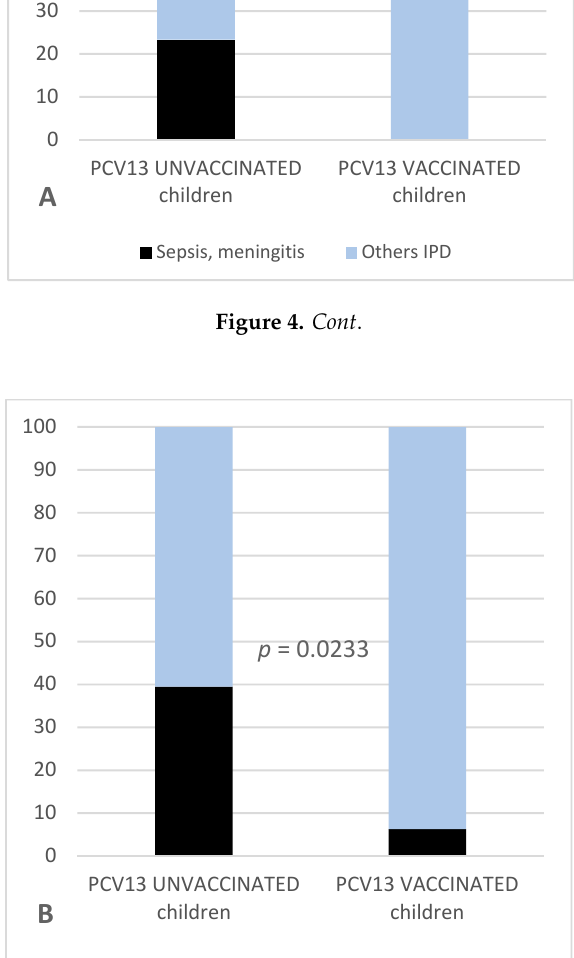
Figure 4. Percentage representation of the different forms of serotype 3 Streptococcus pneumoniae invasive pneumococcal disease (IPD) in children under 8 years of age, vaccinated with PCV13 and unvaccinated. Columns show internal group percentage subdivision based on clinical course severity: black represents sepsis and meningitis in panel A, with the addition of patients admitted to the pediatric intensive care unit (PICU) in panel B ; other less severe forms of IPDs (different types of complicated pneumonias) are represented in light blue. Table 3. Number of cases grouped for infection type in children under 8 years of age with serotype 3 Streptococcus pneumoniae invasive pneumococcal infections and known vaccine status. PCV13 vaccinated children were all born after 2011, while the PCV13 unvaccinated children group was derived from grouping together children born before 2011 plus those born in PCV13 that had not completed their age-appropriate vaccination series at the moment of sample collection. Clinical subgroups are shown below the main groups that are presented in bold.